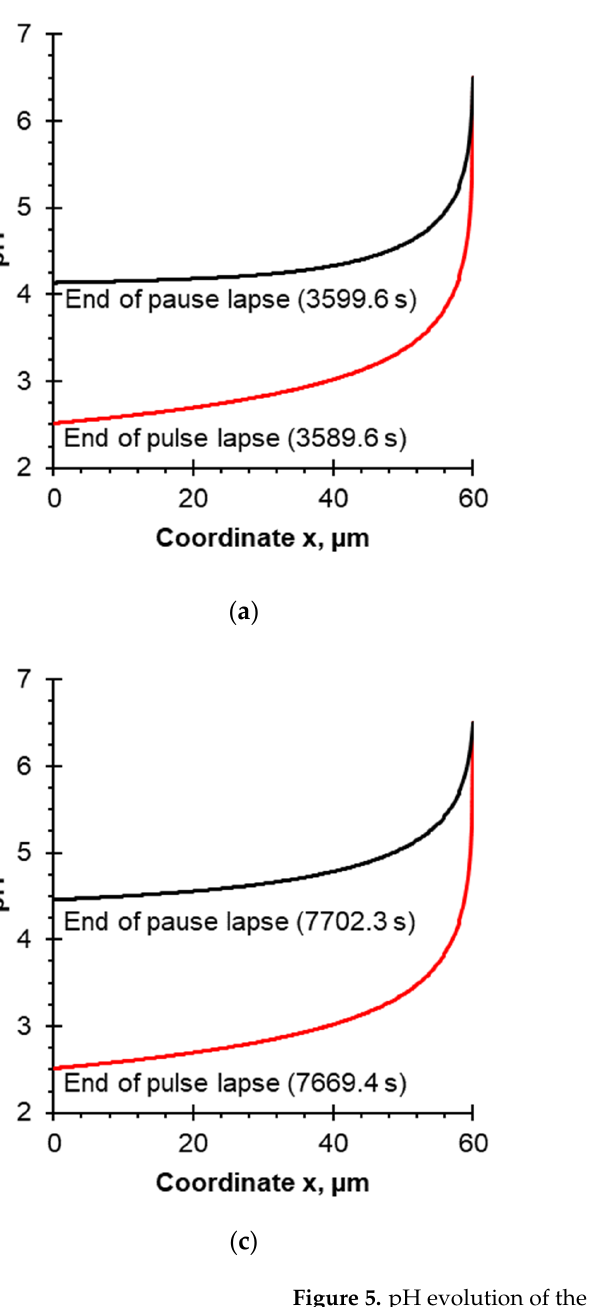
Figure 5. pH evolution of the caseinate solution vs the coordinate. Calculations are performed for δ = 60 µ m and the following PEF modes: ( a ) 10–10 s at the end of the pulse lapse (3589.6 s) and pause lapse (3599.6 s); ( b ) 10–20 s at the end of the pulse lapse (5350.7 s) and pause lapse (5370.3 s); ( c ) 10–33 s at the end of the pulse lapse (7669.4 s) and pause lapse (7702.3 s); ( d ) 10–50 s at the end of the pulse lapse (10,039 s) and pause lapse (10,089 s). The steady-state condition is considered. To the right of the figures, a diagram of the dependence of the charge of casein species on pH is given. It is based on the dependence of the zeta potential values of casein on pH [43] (Figure S3 in